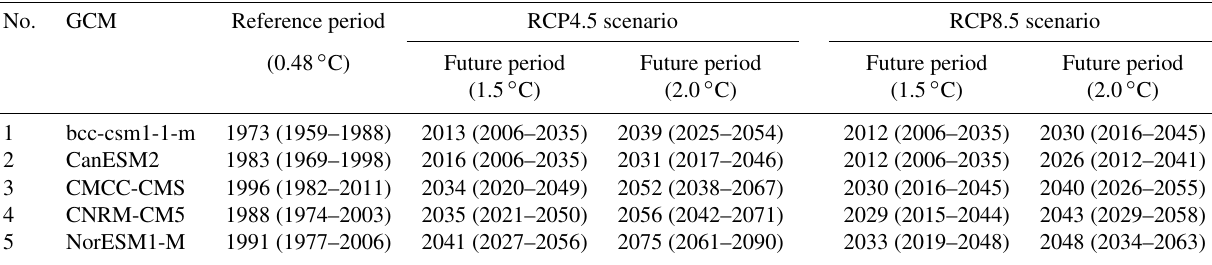
Table 3. Central years (corresponding periods) of the individual GCMs with global warming of 0.48, 1.5, and 2.0 ◦ C under the RCP4.5 and RCP8.5